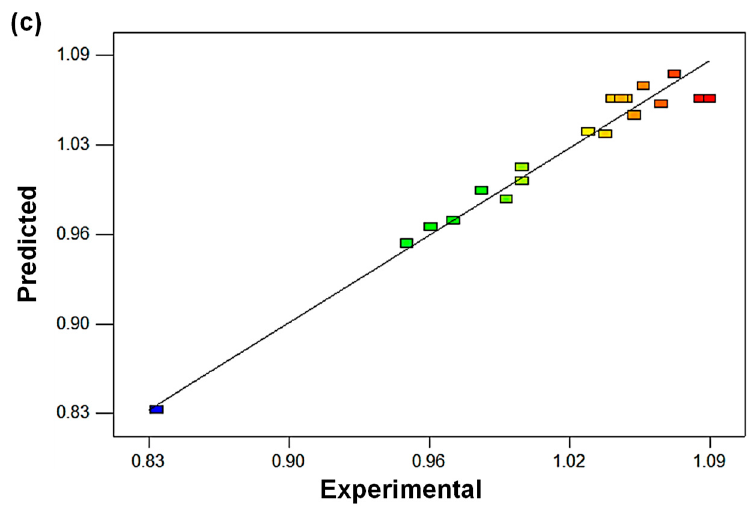
Figure 1. Experimental and predicted values for ( a ) tensile strength, ( b ) flexural strength, and ( c ) flexural modulus of P(HB- co -11% HHx)/CNF bionanocomposites. The polynomial equation in terms of uncoded variables of factors was obtained by exchange of coded variables with actual values as shown in Equations